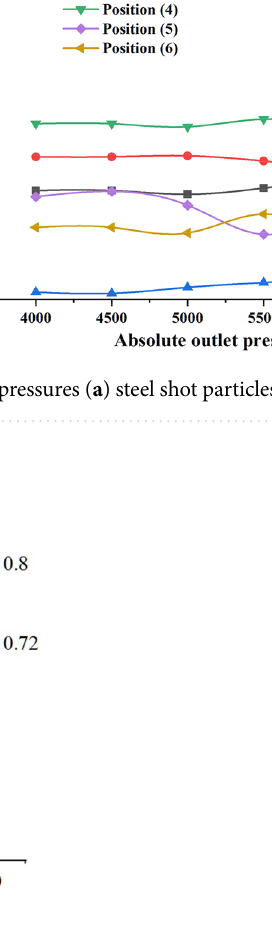
Figure 14. Recovery efficiency of steel shot particles and scrap particles at different absolute pressure